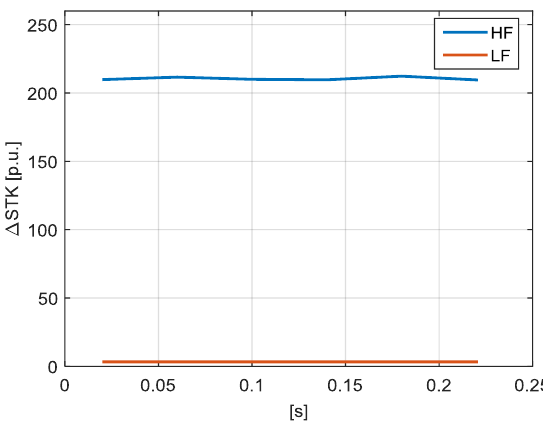
Figure 27. Case study 1: Δ STK at low-frequency (0 ÷ 2 kHz, red line) and at high-frequency (2 ÷ 150 kHz, blue line) obtained through STFT.